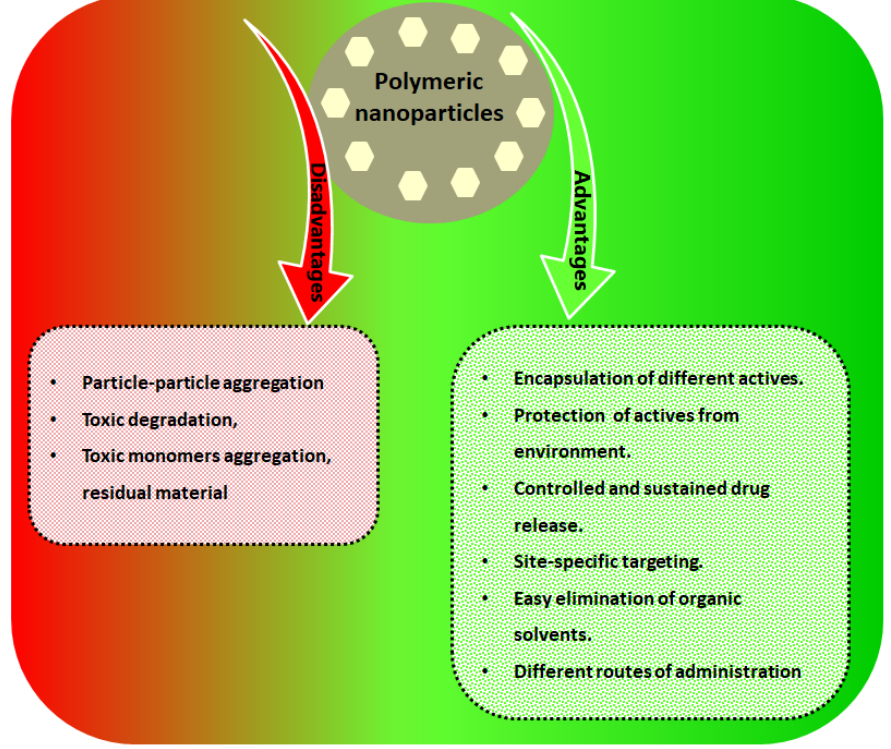
Figure 2. Advantages and disadvantages of polymeric